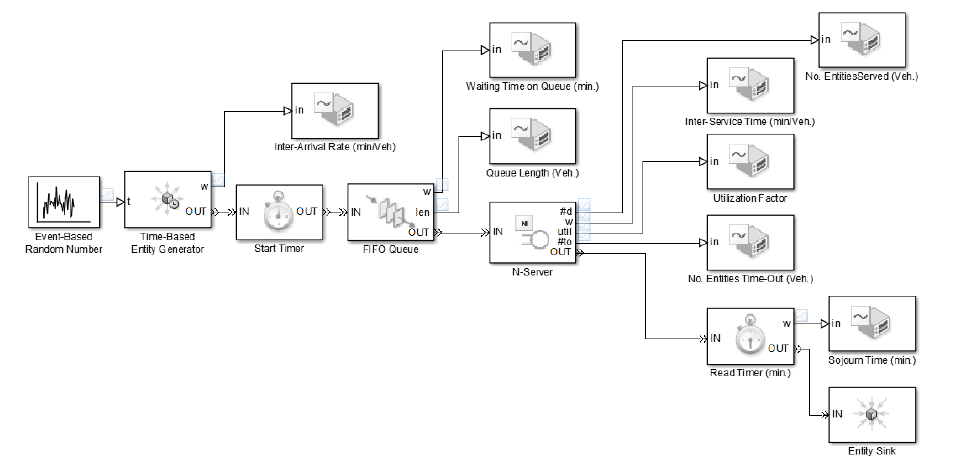
Fig. 4. Simulink Model of Queuing Process at TOTAL Petrol Station in Makurdi Town.